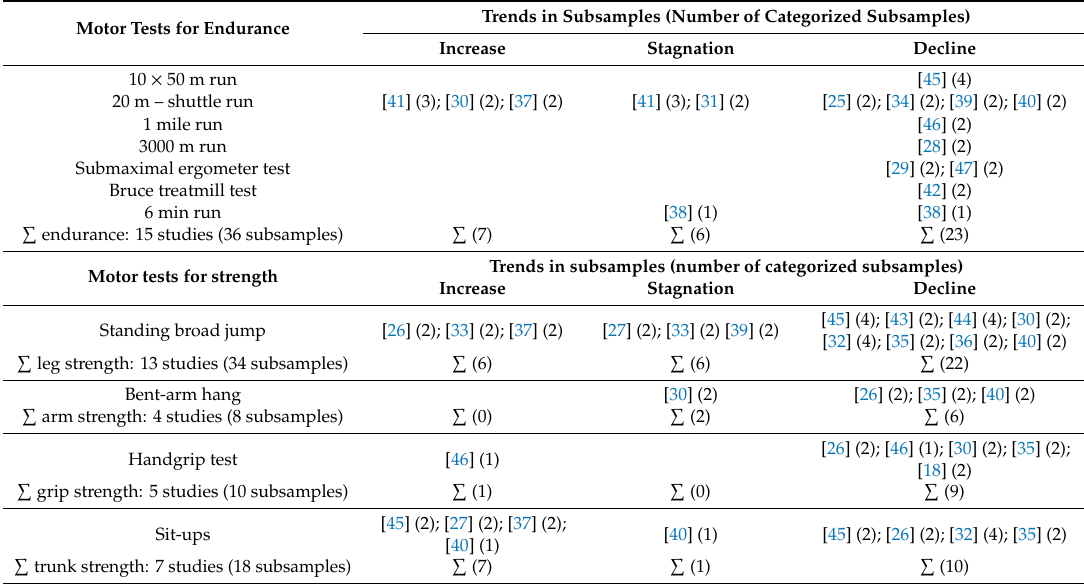
Table 2. Results of trends in PF for the specific dimensions of PF. A significant result is rated as increase or decrease; a nonsignificant result is rated as